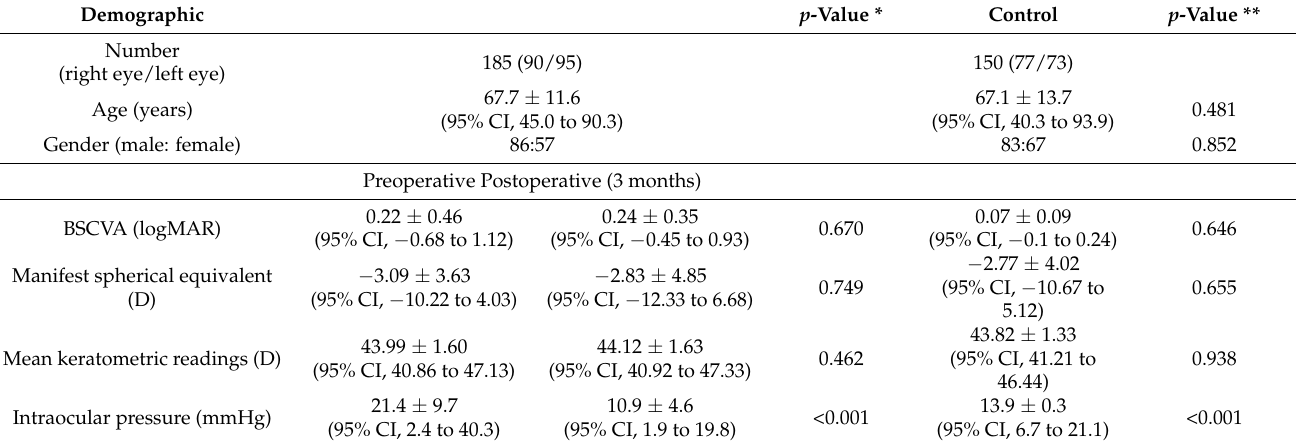
Figure 2. Graph showing the distributions of the arithmetic mean of surgically induced astigmatism (M-SIA).